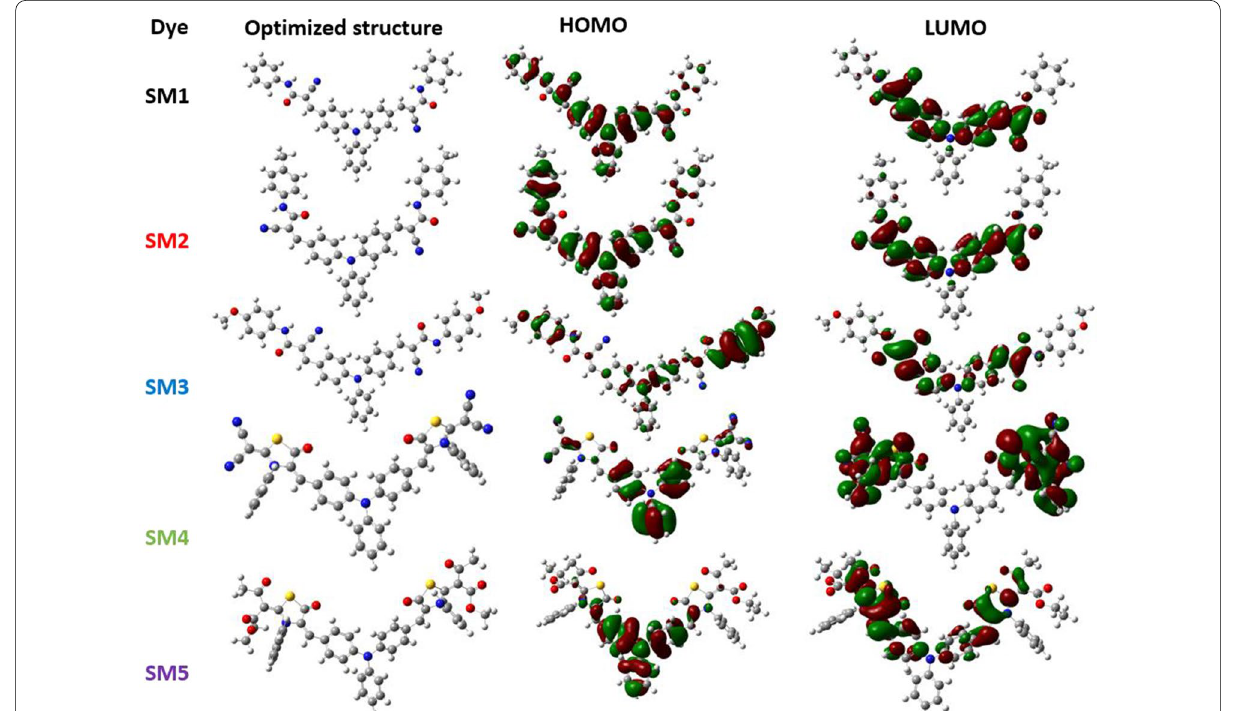
Fig. 8 Optimized structures and molecular orbital distributions of SM1‑5